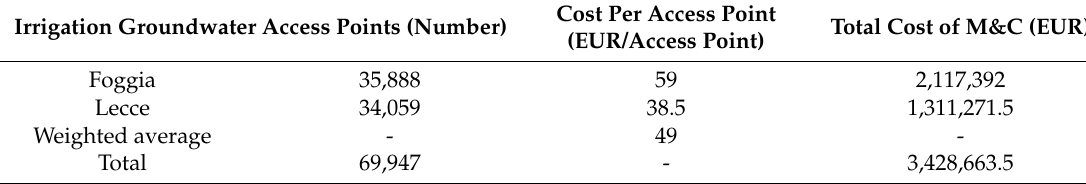
Table 8. Total cost of M&C for the Provinces of Foggia and